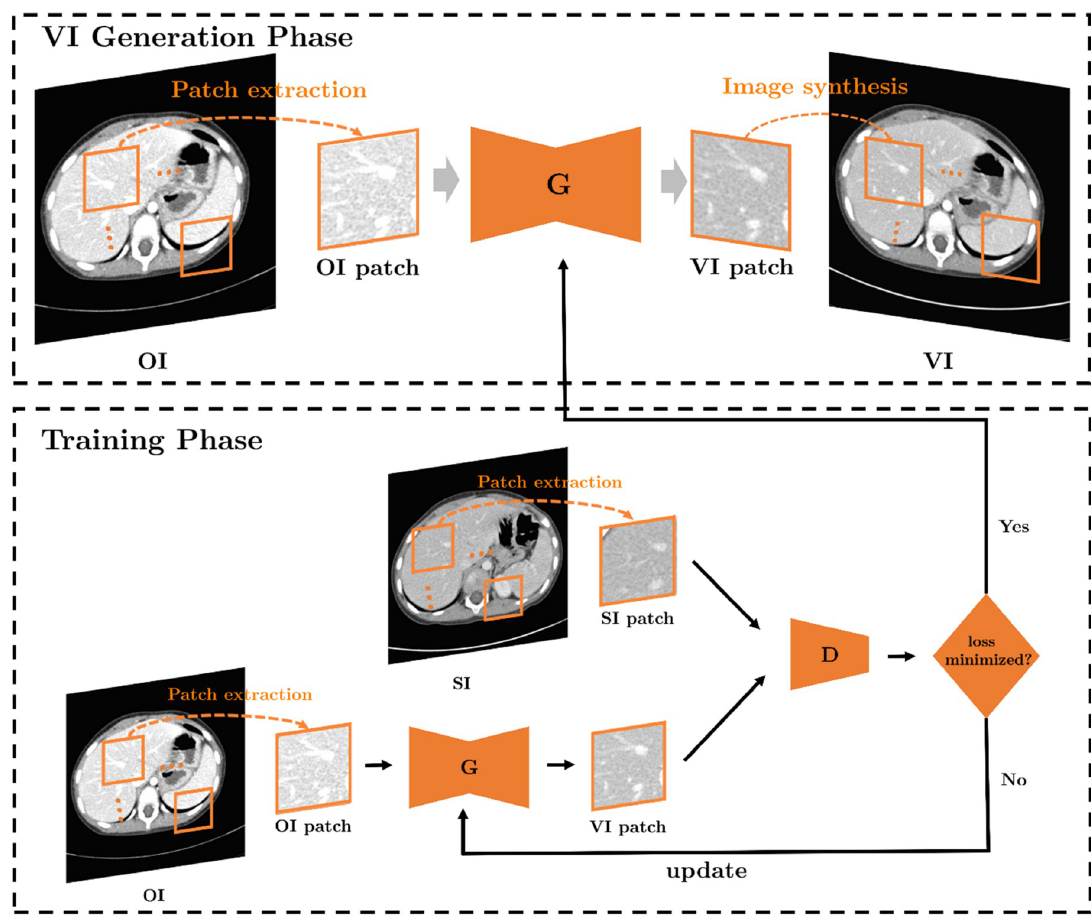
Fig 2. Schematic of the VIGAN. The VI generation is performed in a patch-by-patch manner by the trained generator. G = generator, D = discriminator. VI = virtual standard-dose CT images, OI = original low-dose CT image, SI = real standard-dose CT image.